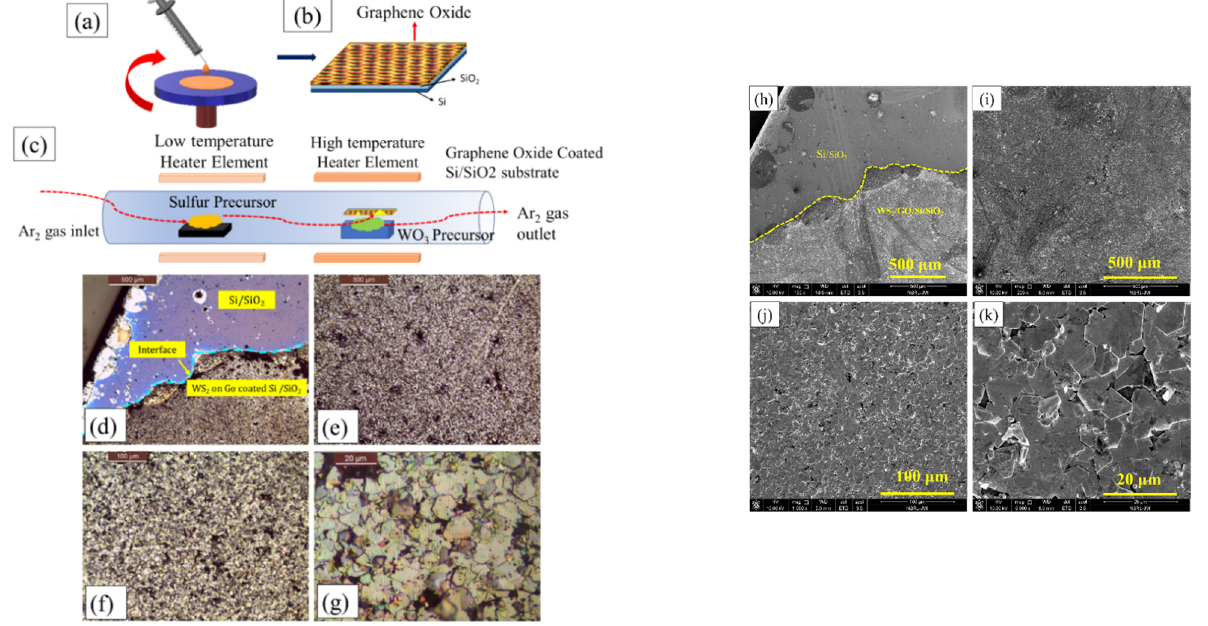
Figure 8. ( a ) Spin coating GO solution over Si/SiO 2 substrate, ( b ) GO coated Si/SiO 2 substrate, ( c ) CVD experimental setup used for WS 2 growth, and ( d – g ) optical microscope images of WS 2 grown on GO coated Si/SiO 2 substrate, and ( h – k ) FESEM micrographs of WS 2 grown over GO coated Si/SiO 2 substrate.